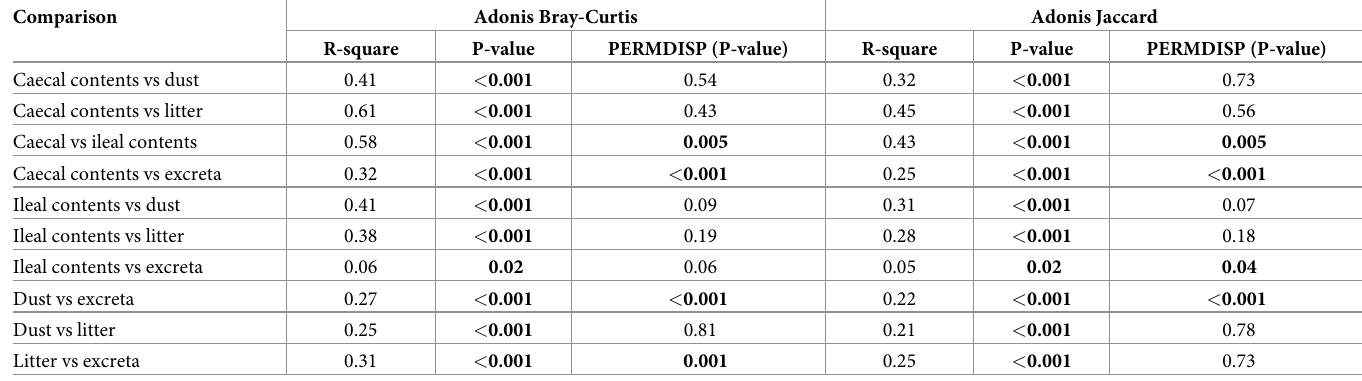
Table 1. Difference in the microbial community between the two groups measured using permutational multivariate analysis of variances (PERMANOVA) on Bray–Curtis and Jaccard distance metrics using the Adonis function. Comparison Adonis